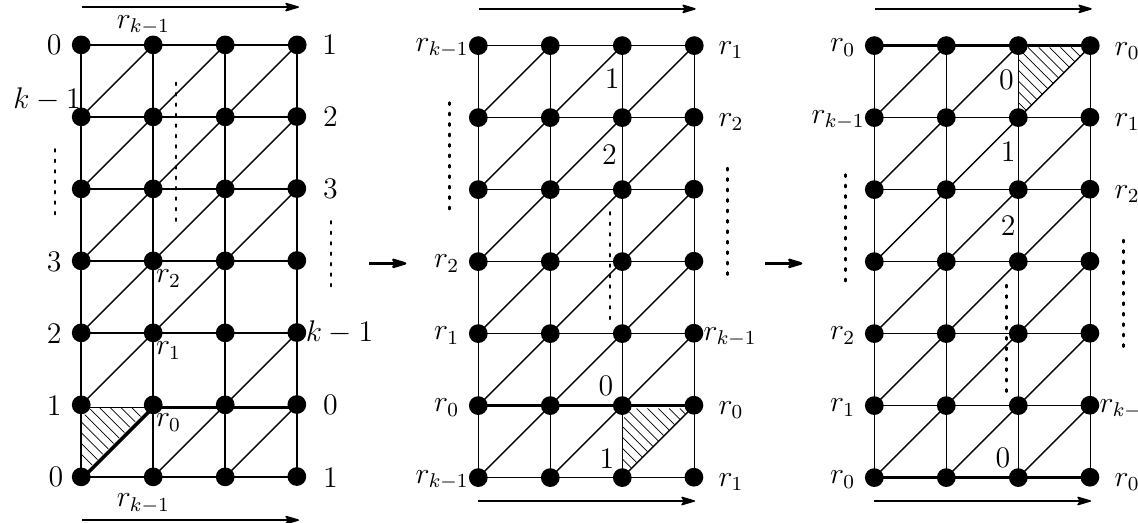
into H (cid:3) by cut and k;m;b k;m;a